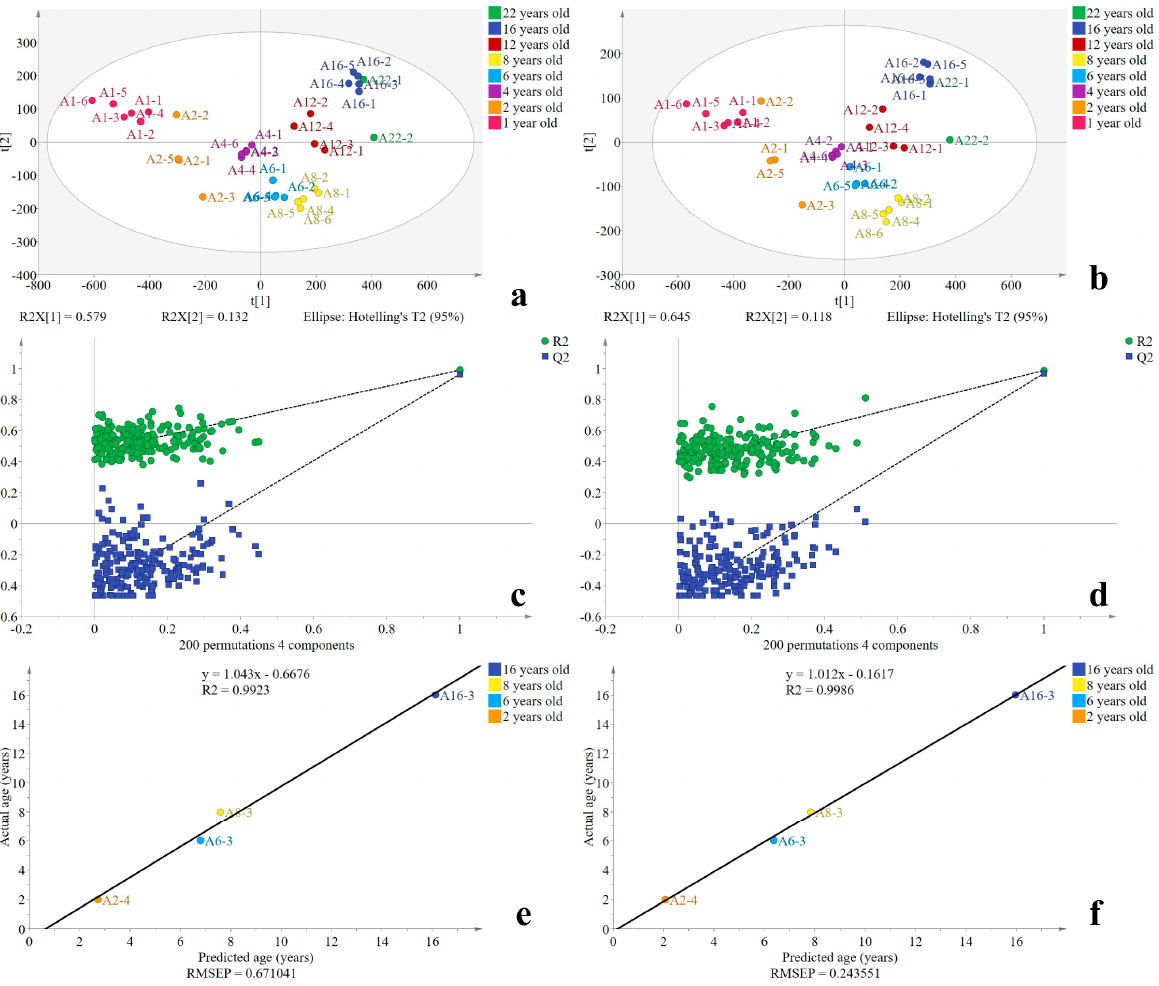
Figure 4. ( a , b ) Score scatter plots, ( c , d ) permutation test results ( n = 200), and ( e , f ) graphs comparing the actual age and predicted age of the models. ( a , c , e ) Plots correspond to Model A. ( b , d , f ) Plots correspond to Model B.